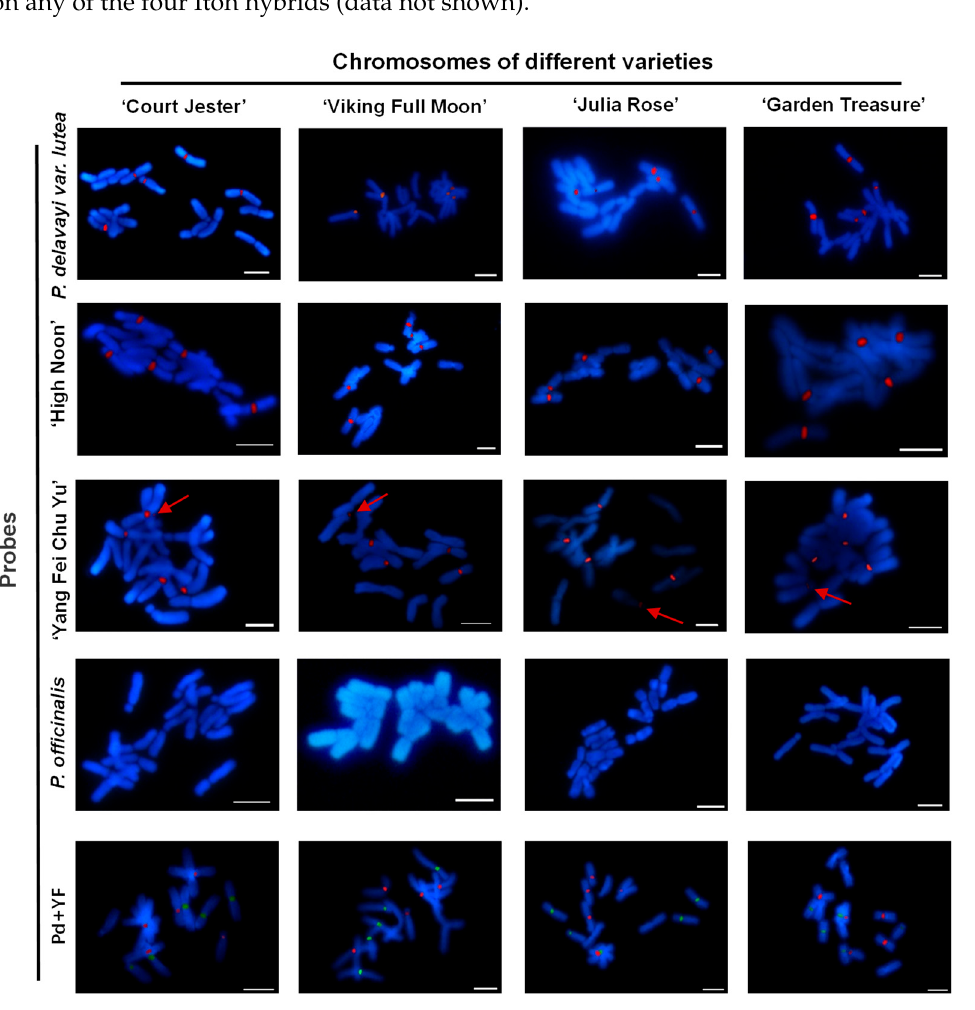
Figure 5. Comparative GISH mapping of four representative Itoh hybrids using gDNA of selected species or varieties as probes. Pd + YF indicates the mixed probes with P. delavayi var. lutea (green) and ‘Yang Fei Chu Yu’ (red). The red arrows indicate the labeled chromosomes with weak signals. Bar = 10 μ m.